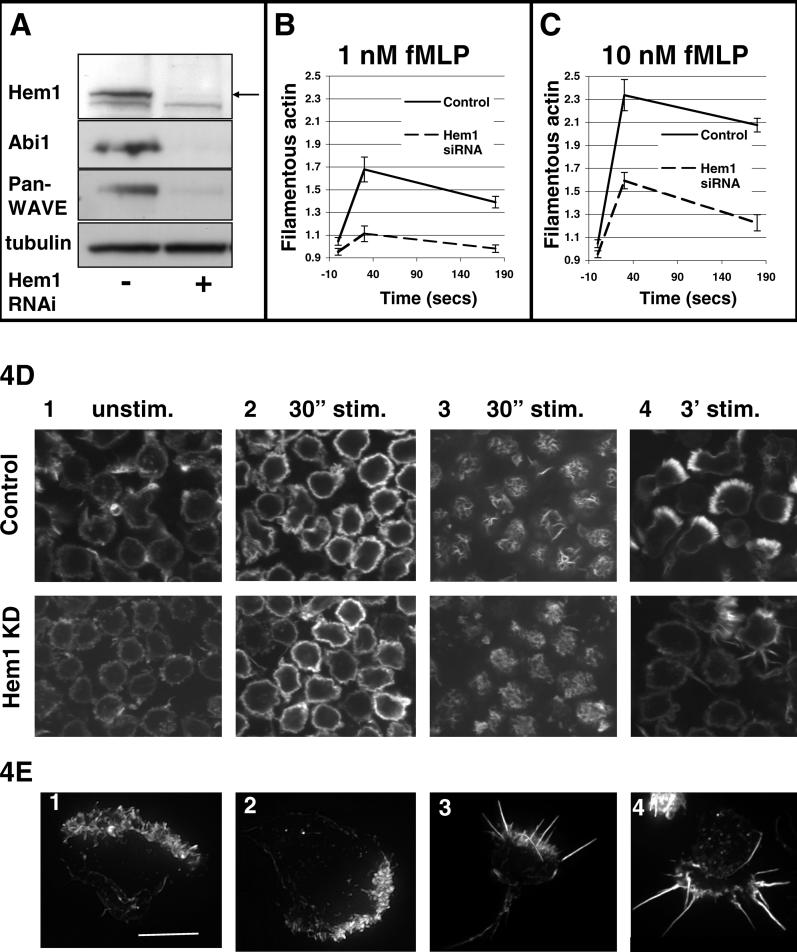
Actin Polymerization and Polarity Are Dependent on Hem-1(A) RNAi-mediated inhibition of endogenous Hem-1 protein expression and degradation of WAVE complex proteins in HL-60 cells. Whole cell lysates were prepared from control cells and siRNA-expressing cells as described. Equal amounts of lysate were used to determine expression of Hem-1, Abi-1, and pan-WAVE by Western blotting. Tubulin levels are shown as a loading control.(B, C) Actin polymerization is dependent on Hem-1. Differentiated HL-60 cells were treated with or without 1 nM fMLP (B) or 10 nM fMLP (C) for 30 s or 3 min, as indicated. After fixation, F-actin content was assessed by staining with Alexa647-conjugated phalloidin and quantified by FACS analysis. Absolute actin levels are shown for each condition (averages of control and Hem-1 knockdown cell Alexa 647 staining was used to normalize for FACS variation and staining intensity between experiments). Standard error of mean for six experiments is shown.(D) Cell polarity is dependent on Hem-1. Control and Hem-1 knockdown cells were stimulated in suspension with or without uniform fMLP (20 nM final concentration) for 30 s or 3 min, fixed and stained with rhodamine phalloidin to visualize filamentous actin, and visualized with spinning disk confocal microscopy. Unstimulated cells are nonpolar with minimal filamentous actin accumulation (1). Both control and knockdown cells uniformly accumulate F-actin at 30 s following stimulation (2). However, knockdown cells exhibit a more diffuse actin accumulation than control cells (3 is focal plane at top surface of cells in 2). Following 3 min of stimulation (4), 80% of wild-type cells polarize (1,106 of 1,387), compared with only 19% of Hem-1 knockdown cells (291 of 1,544).(E) siRNA-mediated Hem-1 silencing alters the morphology of the leading edge. Adherent cells were stimulated by a uniform concentration of fMLP (10 nM) for 3 min, fixed, and stained with rhodamine-conjugated phalloidin. Fluorescent images were captured as described. (1, 2) Control cells. (3, 4) Hem-1 knockdown cells. Fifty-five percent of Hem-1 knockdown cells (110 of 200) and 4.4% of control cells (11 of 248) exhibit spikes at the leading edge.